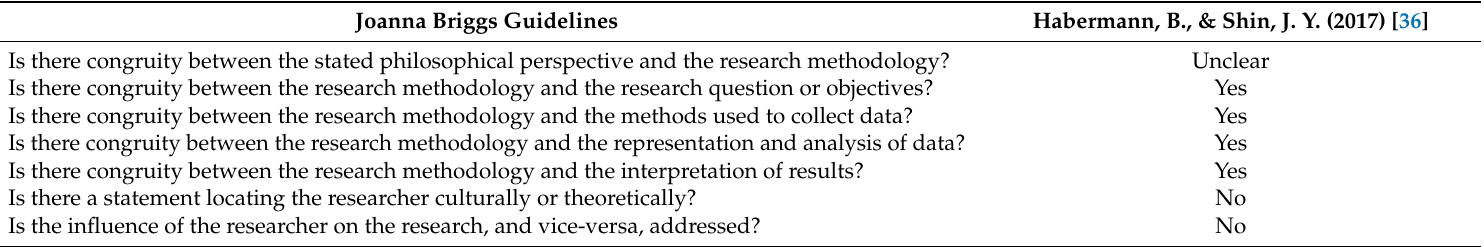
Table 4. Joanna Briggs Institute risk of bias ratings for the qualitative study